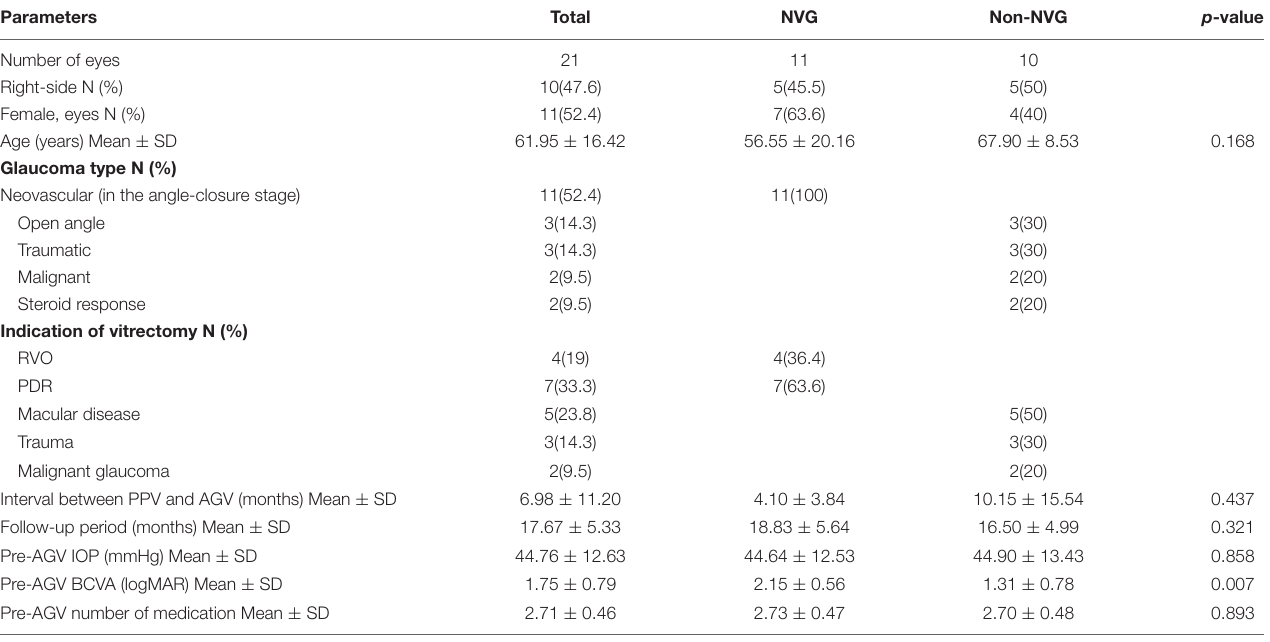
TABLE 1 | Baseline characteristics of patients before pars plana Ahmed valve implantation surgery. Parameters